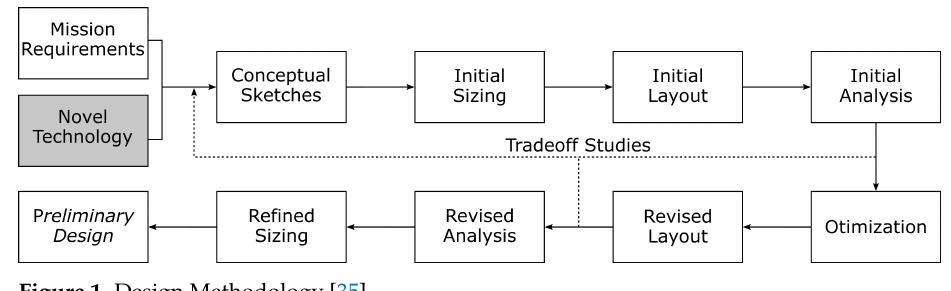
Figure 1. Design Methodology [35].